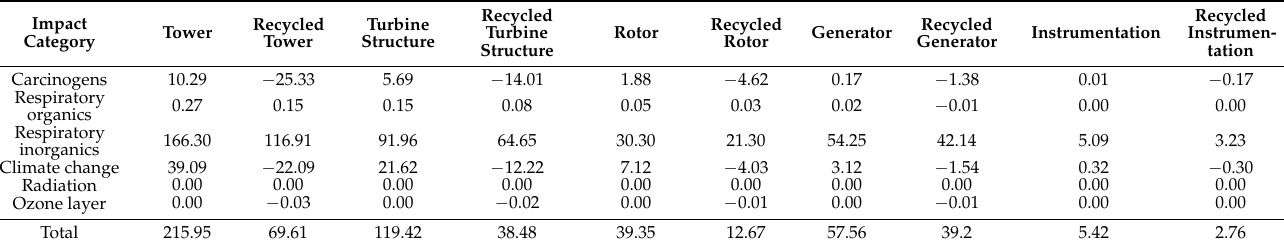
Table 4. Results of grouping and weighting—human health (unit: Pt/1